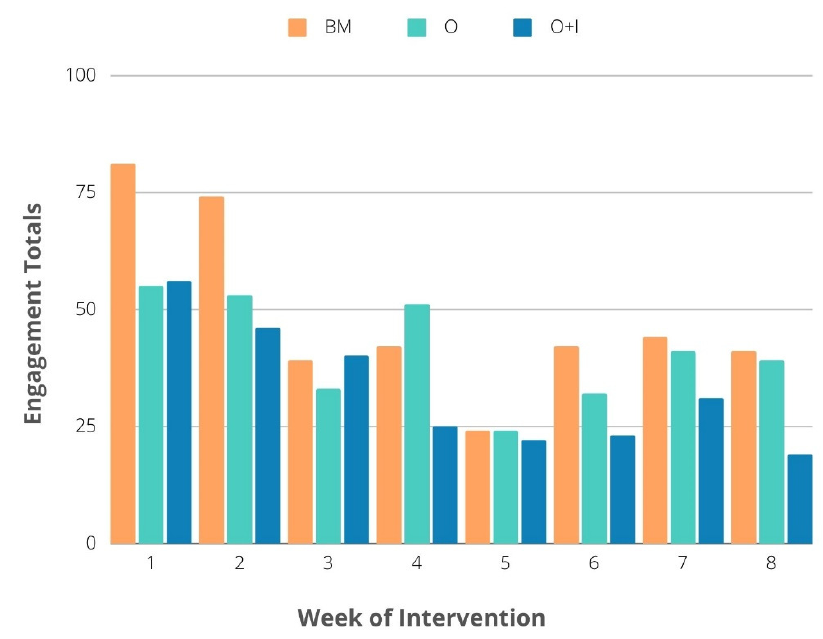
Figure 3. Engagement metrics across the three study arms for the eight-week intervention.